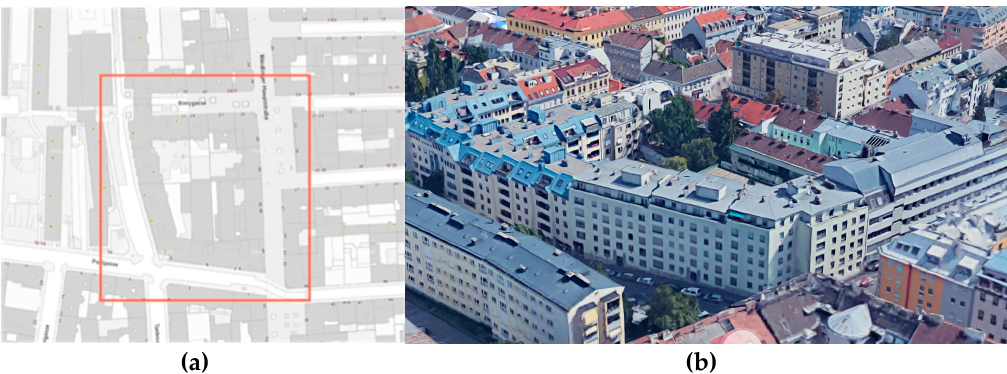
Figure 5. Partial land use map of the City of Vienna with the selected district highlighted in red ( a ) and aerial view of the selected district ( b ) [56,57].